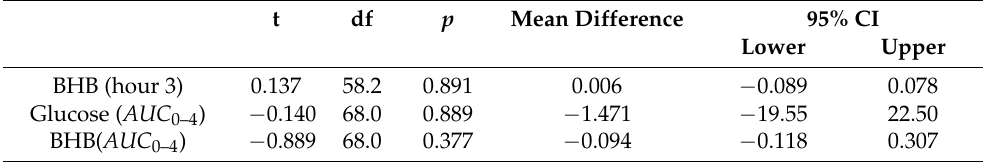
Table 4. Student’s t distribution for mean difference for non-inferiority margin.